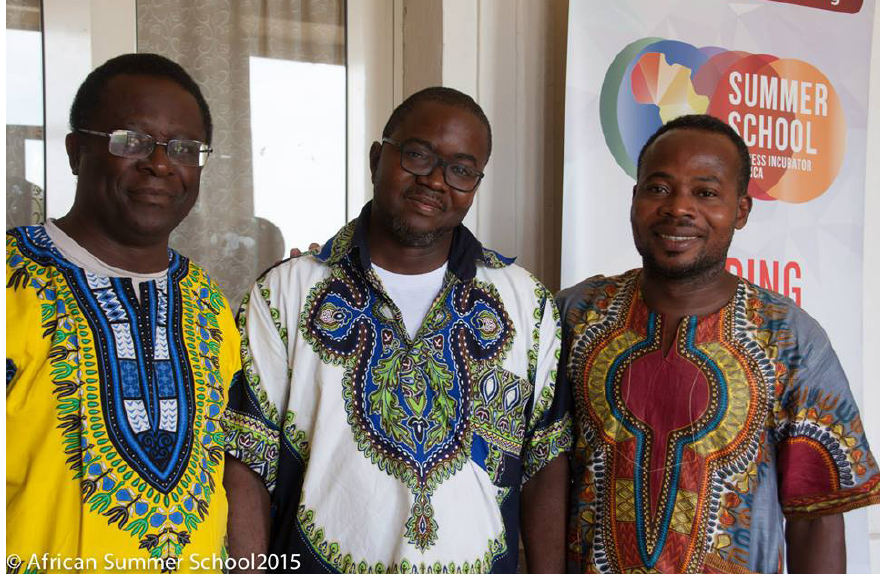
Figure 3 . The professors of the third edition, coming from France, Belgium and Togo (starting from the left), from the African Summer School website,